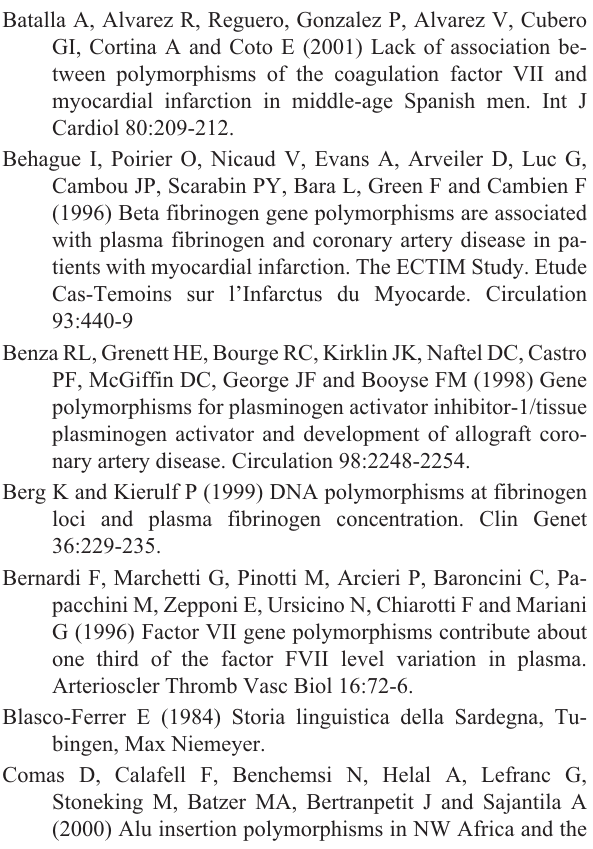
Figure 1 - Neighbour-joinig tree for 6 of the 9 loci analysed in the studied